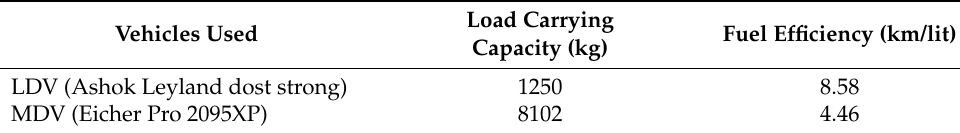
Table 2. Fuel efficiency of vehicles.